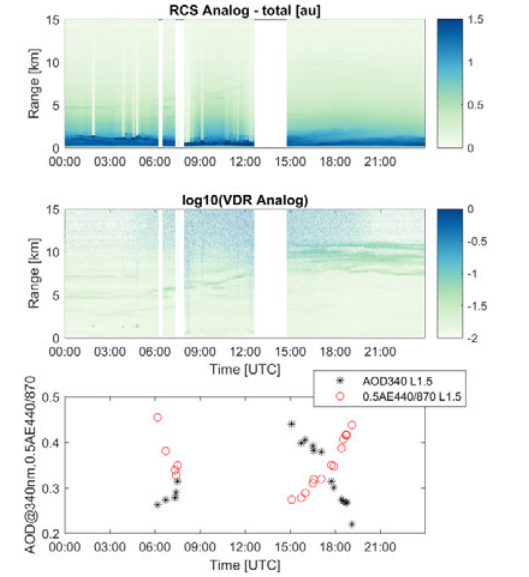
Figure 4. RCS (upper), VDR (middle) and AOD and AE (lower) at Exeter (van) on 26/05/2016 during a biomass burning